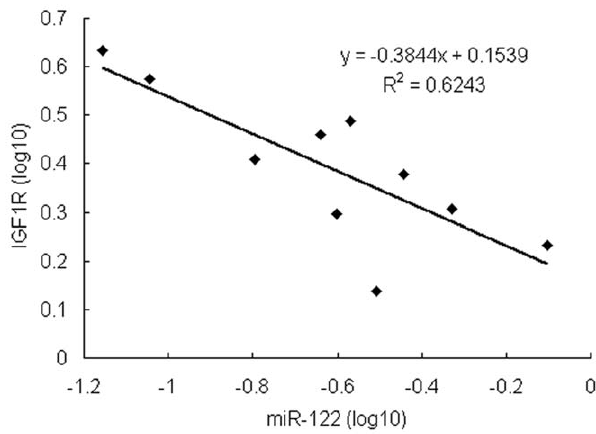
Figure 8. The expression of miR-122 and IGF1R is negatively correlated in clinical BC tissues. There may be an inverse relationship between the expression of miR-122 and IGF1R.